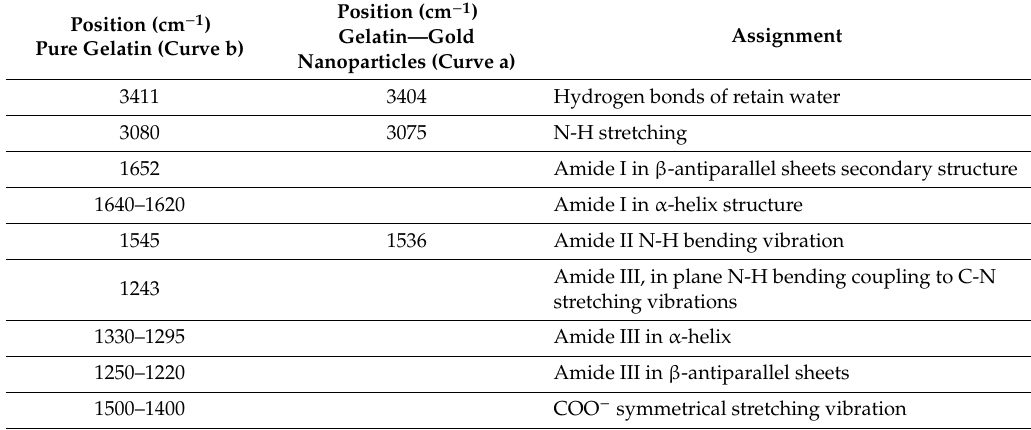
Table 5. Growth inhibitor value of fibroblast cells incubated with AuNPs and AuNPs-gelatin. Sample